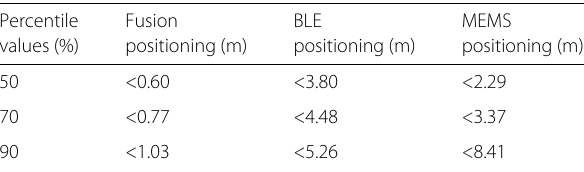
Table 3 Different percentile values with respect to the positioning error